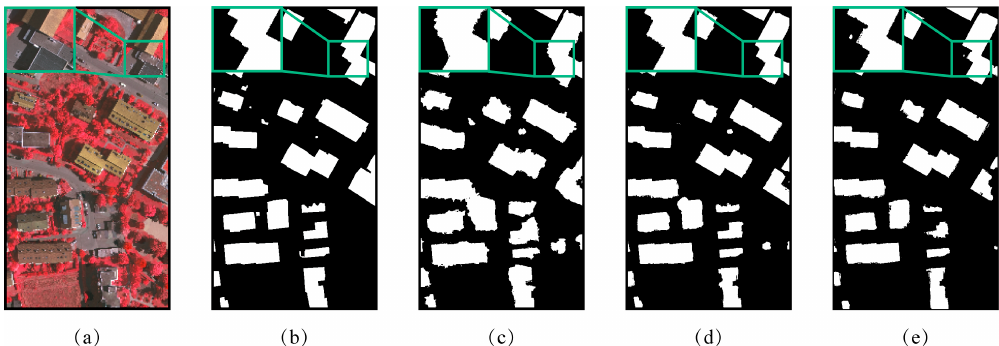
Figure 11. The results of the guided filter. ( a ) The imagery of the urban district. ( b ) The ground truth corresponding with the imagery. ( c ) The optimization result with a guided filter with a threshold t = 40. ( d ) The optimization result with a guided filter with a threshold of t = 90. ( e ) The optimization result with a guided filter with a threshold of t = 165.